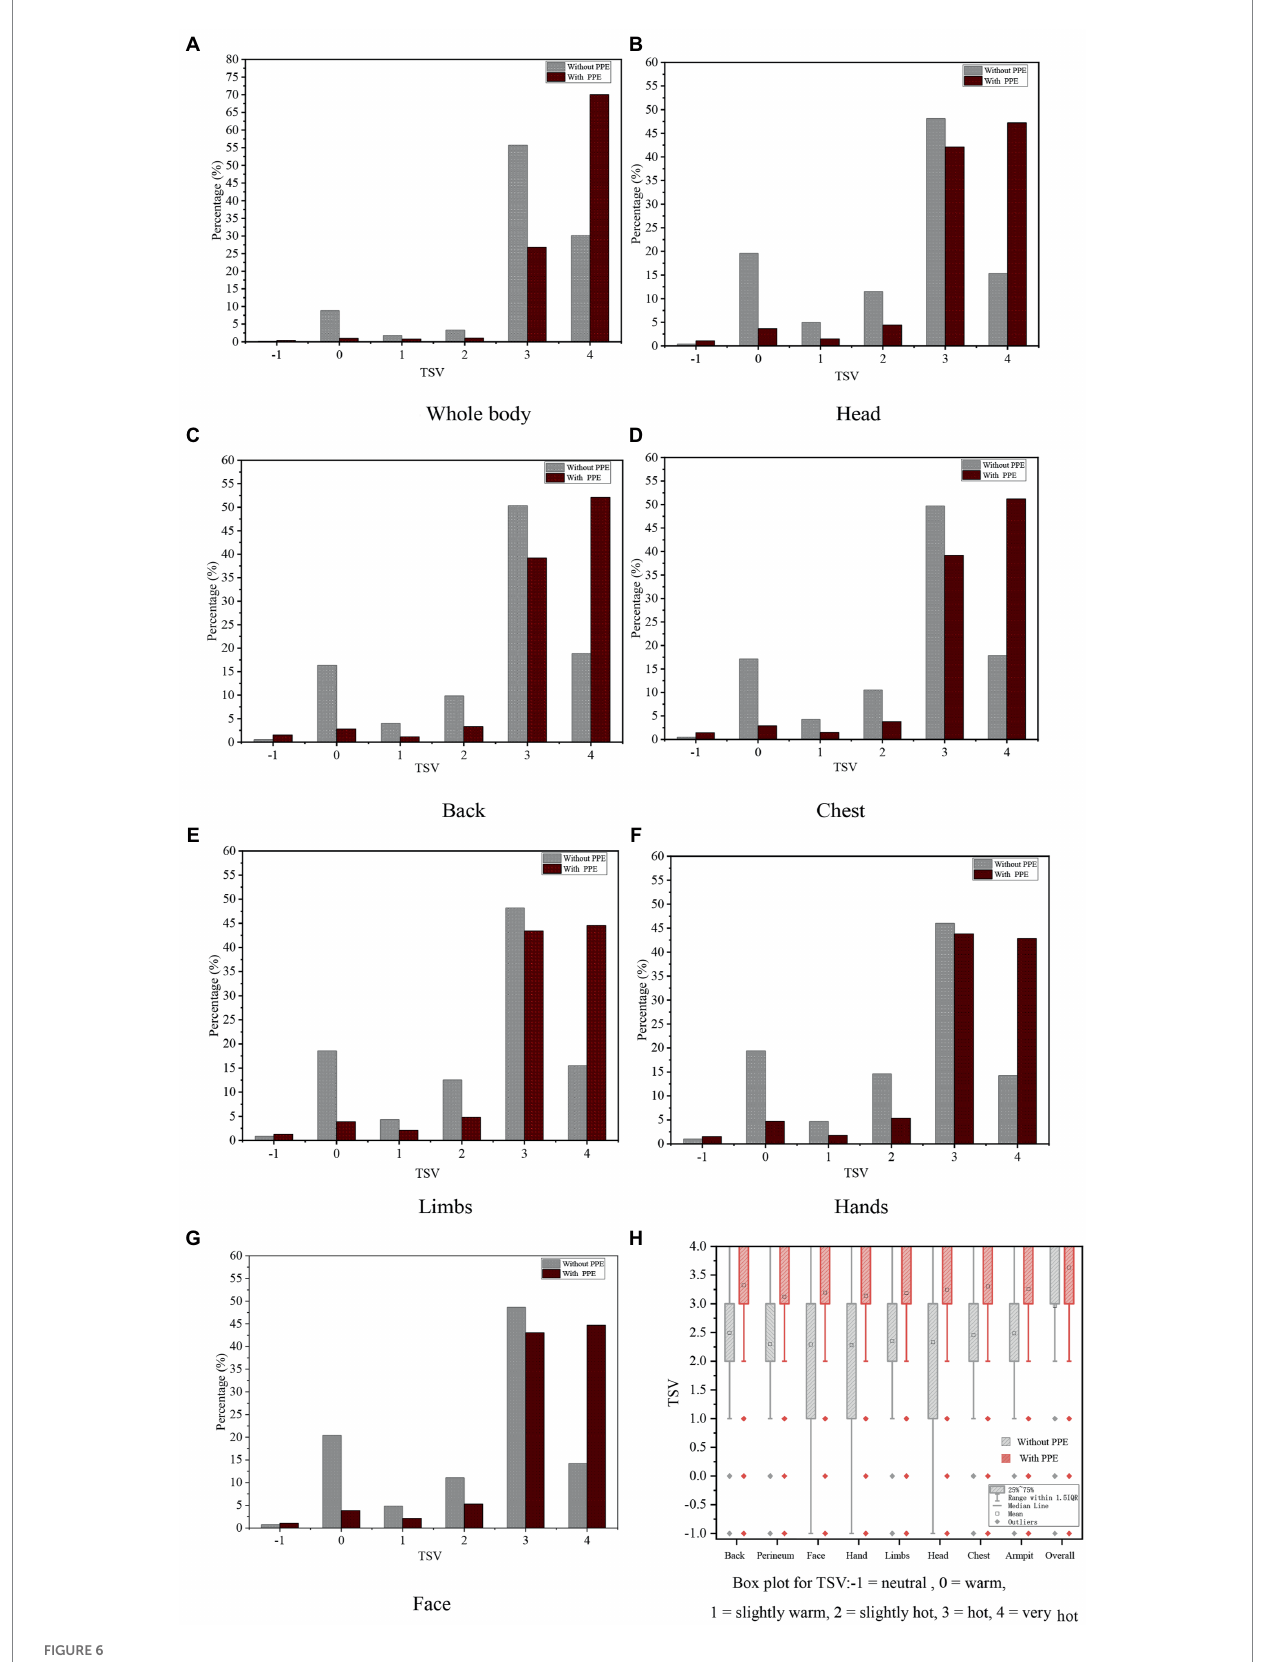
FIGURE 6 Distribution of the